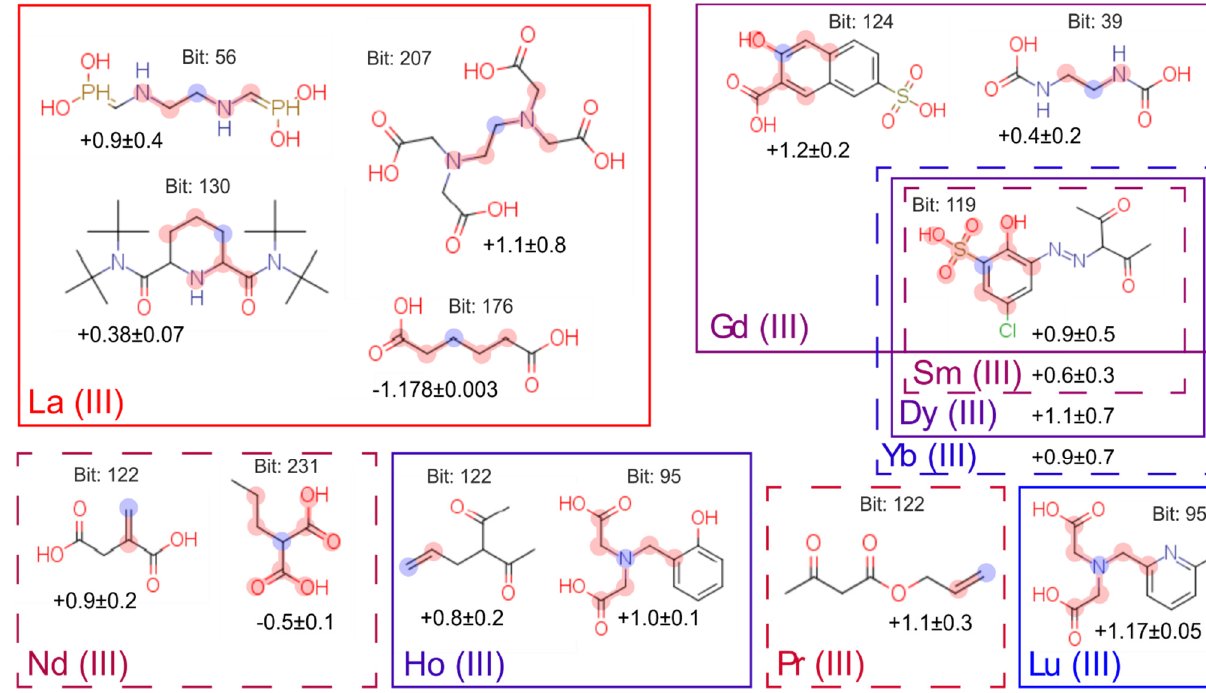
Figure 6. Fragments of molecules significant for Ln(III) complexation. Fragments are signed with red (blue for central atom according to Morgan algorithm); values of additive impact to stability constant are undersigned for each metal.